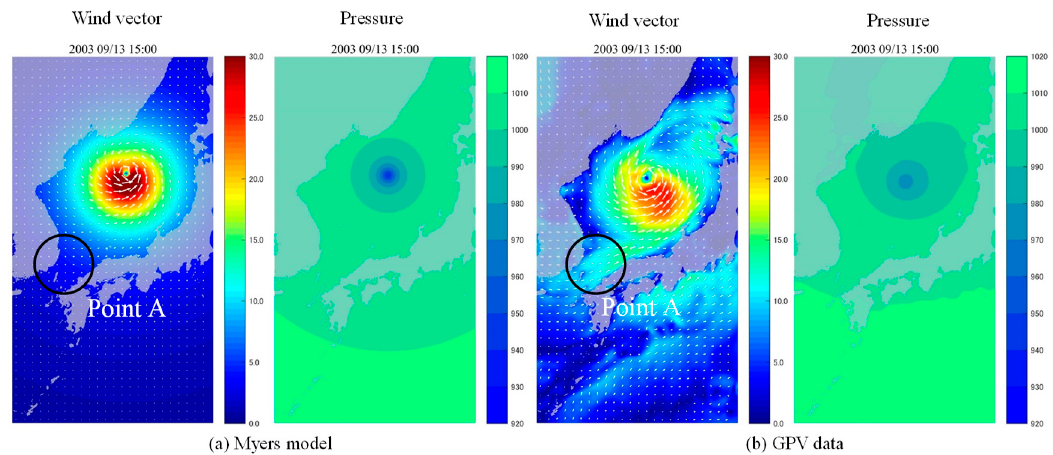
Figure 7. The results of wind vector and pressure based on typhoon models.